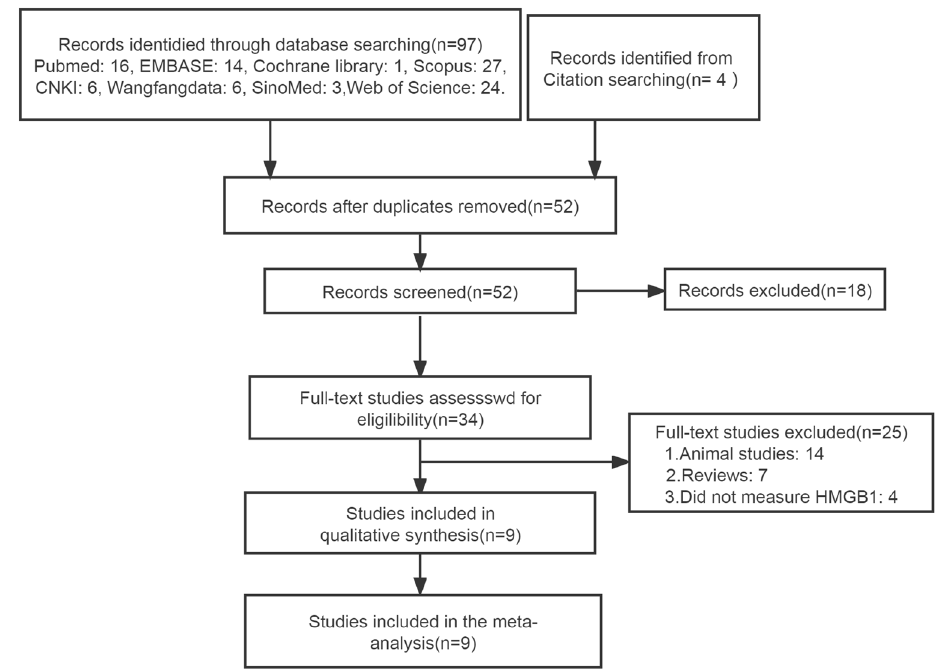
Figure 1. Flowchart of the literature search and study